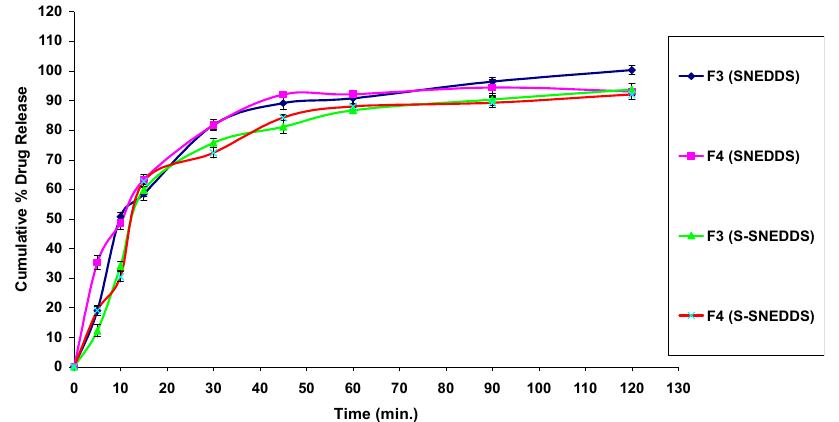
Figure 11. Comparison study of in vitro release profiles of OLM SNEDDS formulae and S-SNEDDS formulae (F3 & F4).